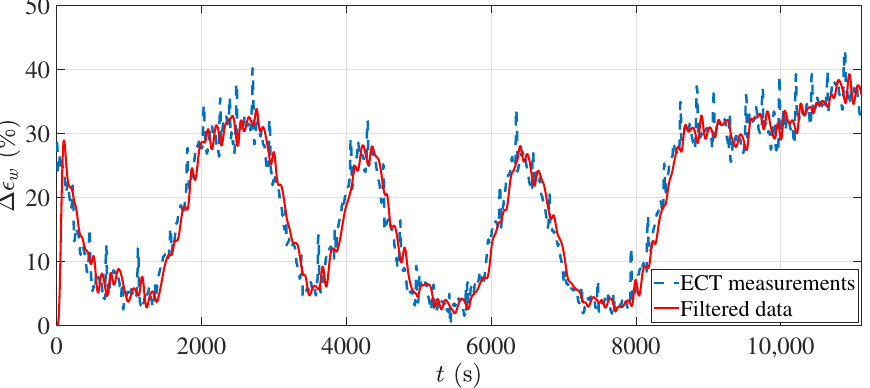
Figure 6. The collected ECT sensor measurements before and after employing a stopband filter.